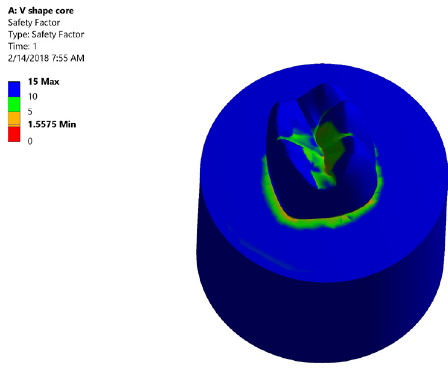
Figure 10. Color graphics showing safety factor of Group